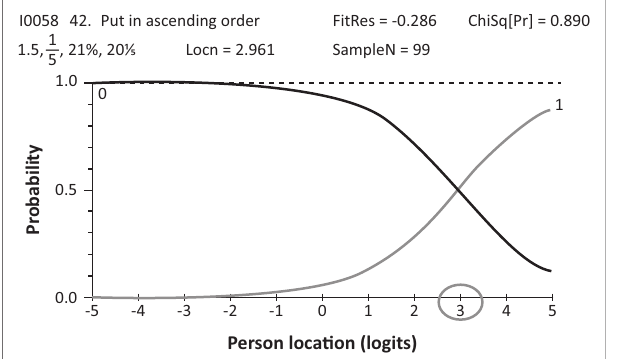
FIGURE 5: Item 63 – category probability